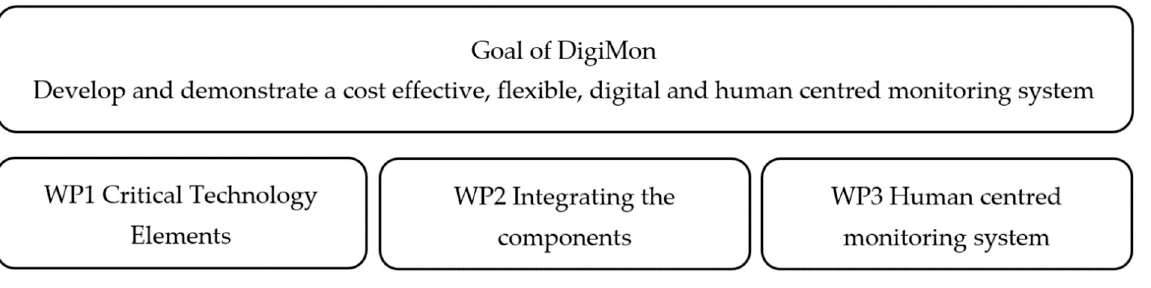
Figure 1. DigiMon work packages and research organization.